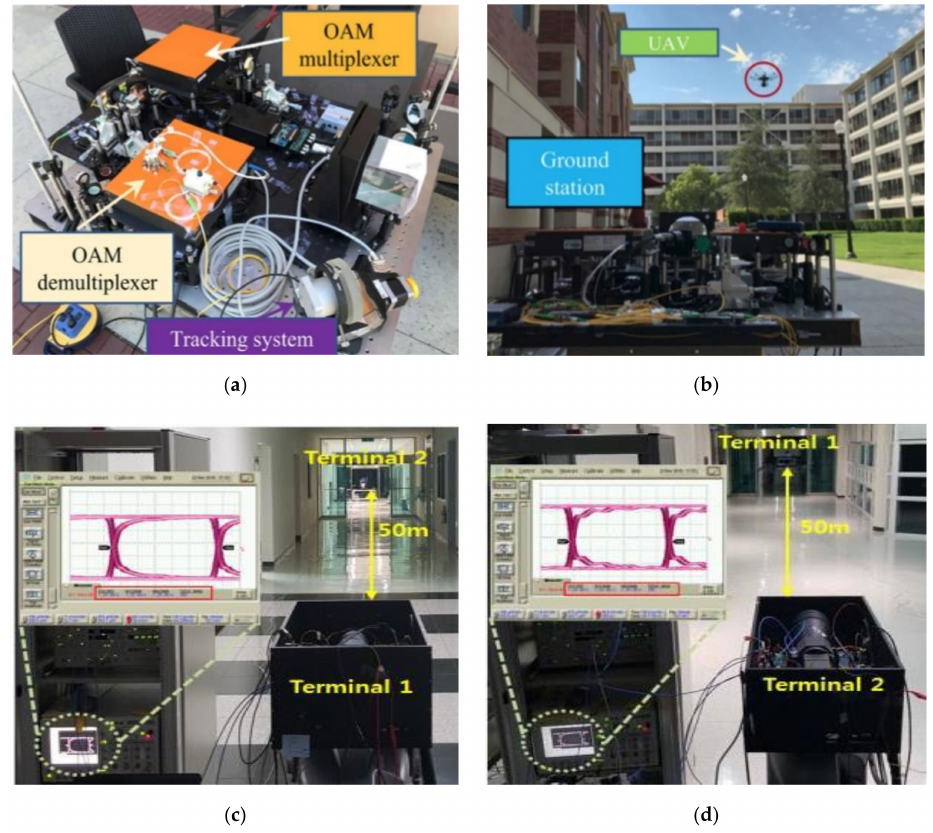
Figure 14. Photos of experimental equipment. ( a ) Ground station; ( b ) communication link between the ground transmitter and the ground receiver via the UAV [127]; ( c ) BER measurement of the WOC link for UAVs (Terminal 1) and GCSs (Terminal 2) from Terminal 1 to Terminal 2; and ( d ) from Terminal 2 to Terminal 1